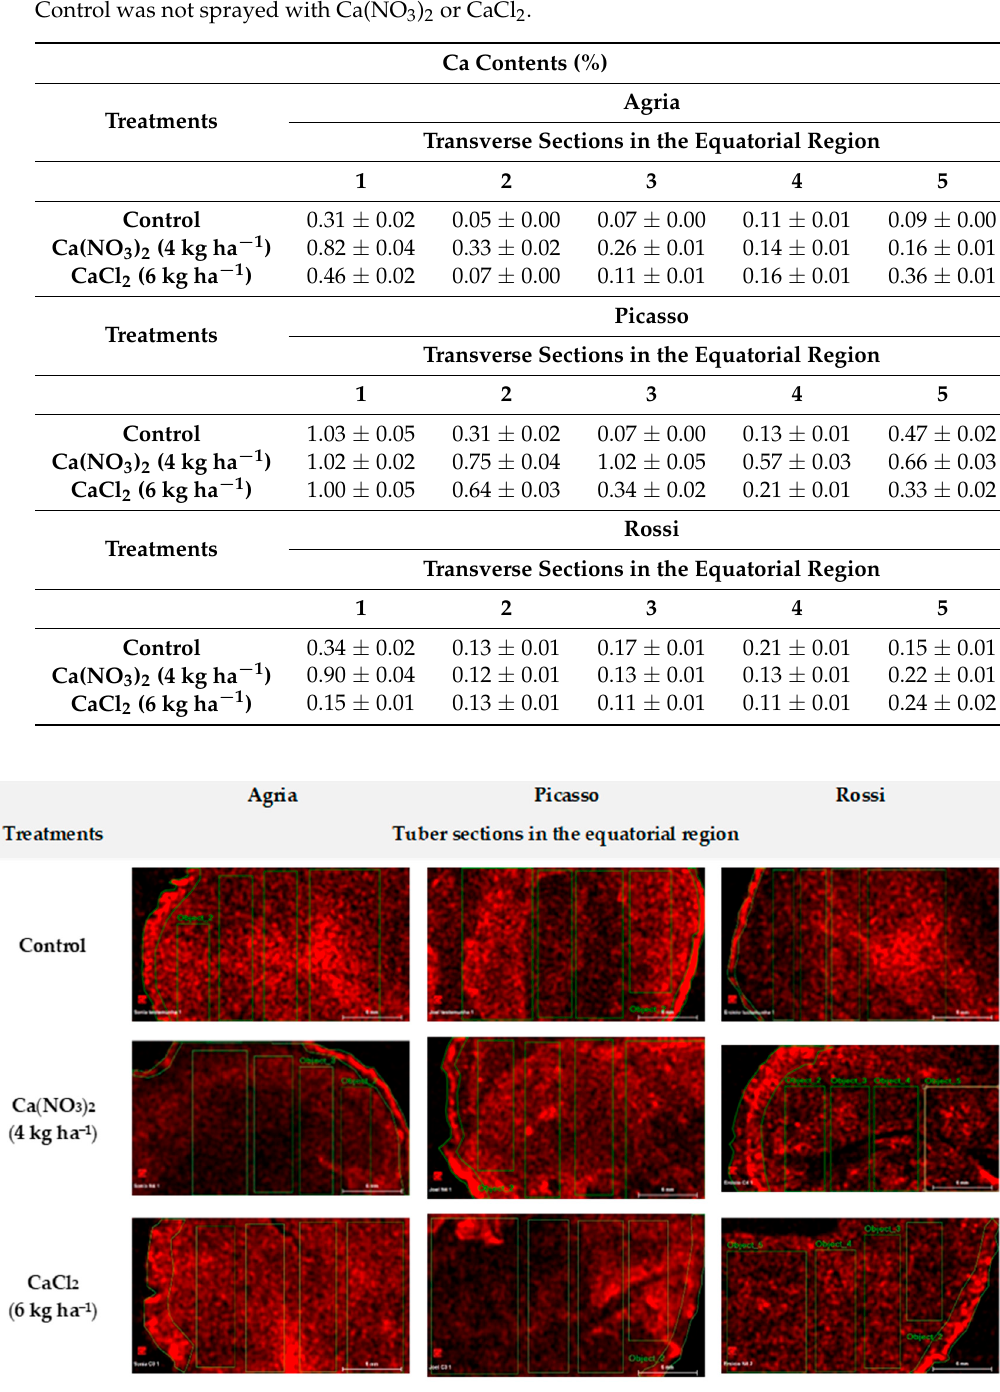
Figure 3. Tuber sections (from the epidermis to the center, 1–5) of each treatment, from the equatorial region of the tubers of S. tuberosum varieties (Agria, Picasso and Rossi), at harvest. Table 3. Average of Ca contents ± S.E. ( n = 4) in 5 transverse sections of the equatorial region (ranging from the epidermis to the center, 1–5), of tubers of Solanum tuberosum L., varieties Agria, Picasso and Rossi, obtained at harvest (control and treated plants with 4 kg.ha − 1 Ca(NO 3 ) 2 and 6 kg.ha − 1 CaCl 2 ). Control was not sprayed with Ca(NO 3 ) 2 or CaCl 2 . Ca Contents ( % )